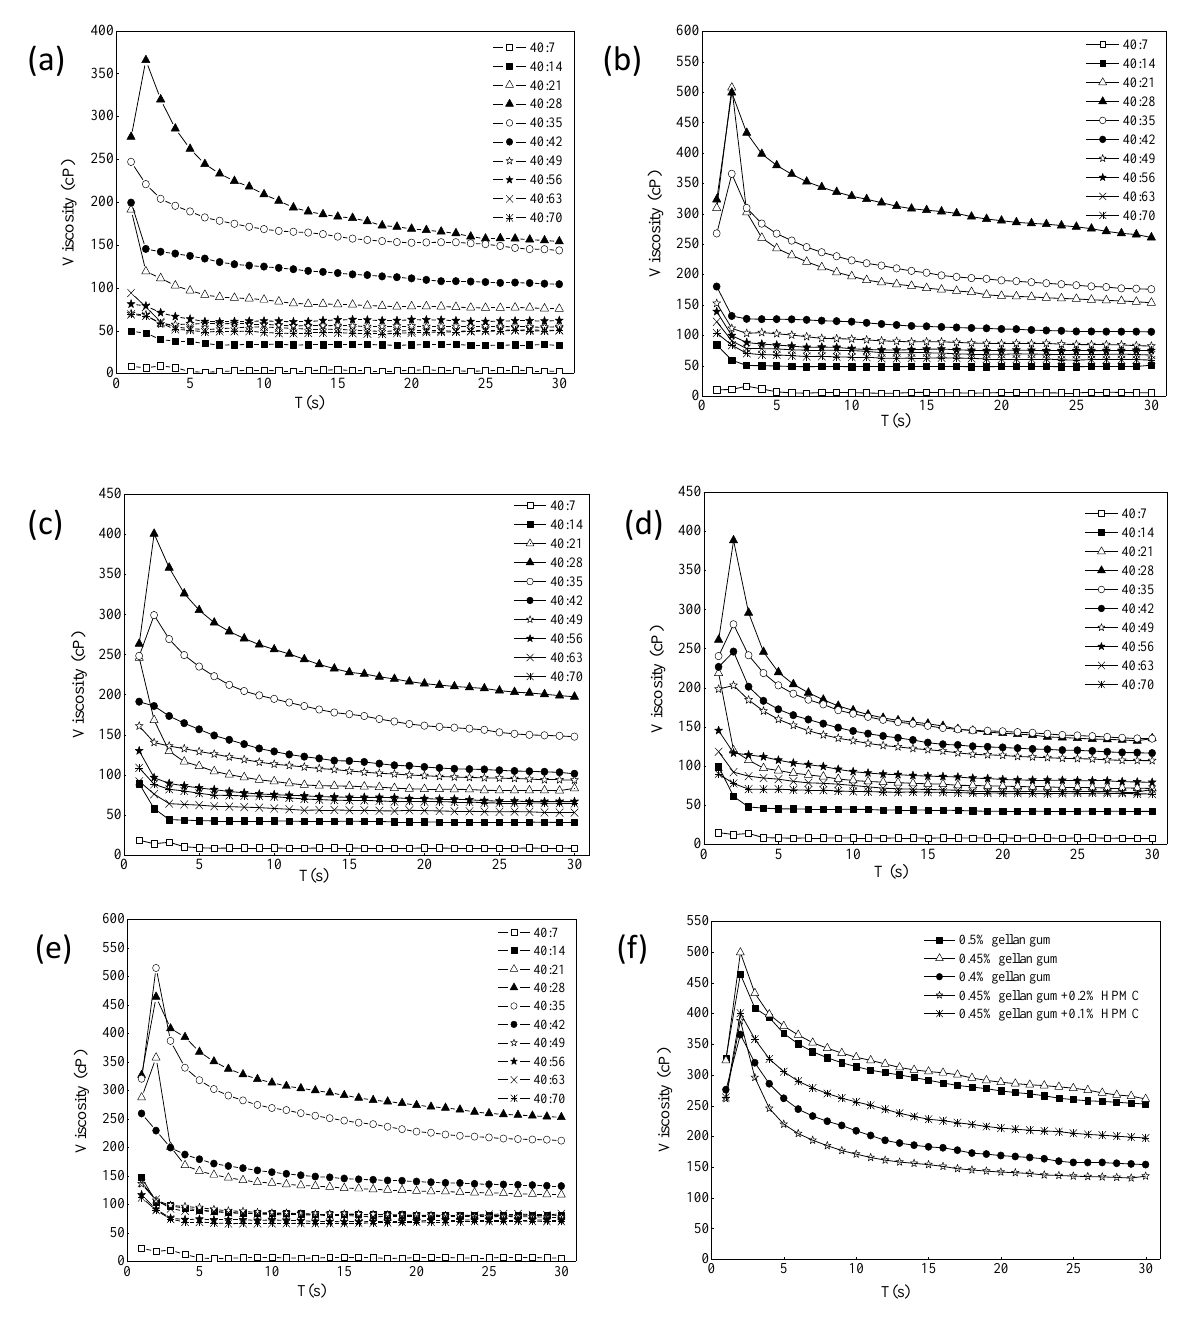
40:28, the viscosity changes of formulation 3 and formulation 6 were the largest, indicating that both formulations had stronger resistance to tear dilution. However, the viscosity of formulation 6 under non-physiological conditions (18.0 cP) was twice that of formulation 3 (8.8 cP), and the liquidity was less than formulation 3. After gellan gum was combined with HPMC, the viscosity change value did not increase significantly, which may be due to the different types of excipients and different measurement conditions from those reported in the literature [14,42]. Therefore, according to the principle of fewer excipients, gellan gum alone was selected as the optimal gel matrix in this study.